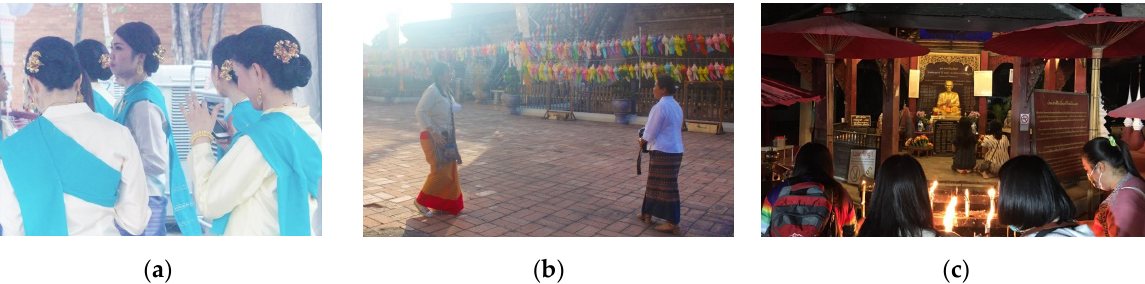
Figure 10. ( a ) Lanna traditional performers in Lanna tradition costume (Author). ( b ) Thai tourists in Lanna dresses (Author). ( c ) Group of people make merits in a temple (Author).